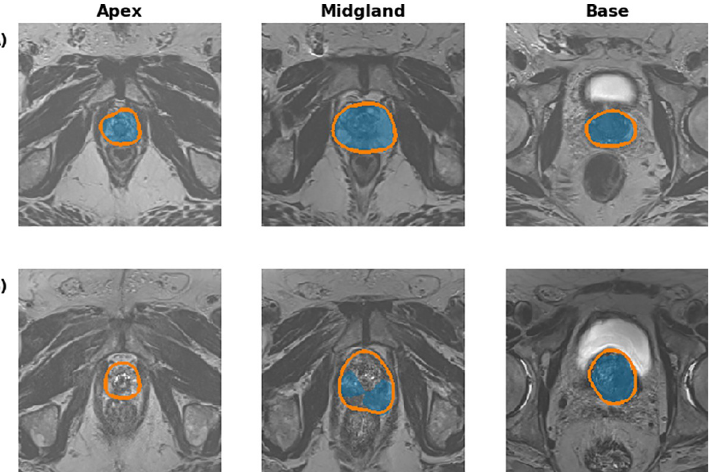
Fig 2. Example UCLA baseline model segmentations. The orange contour depicts ground truth segmentation and the shaded blue area depicts model segmentation. A ) Example apex, midgland, and base slice from a sample in the primary dataset with a high metric on evaluation. The soft Dice coefficient for this sample was 0.928, and the average Hausdorff distance was 0.085. Images of all of the slices for this study are presented in S1 Fig. B ) Example apex, midgland, and base slice from a sample in the primary dataset with a low metric on evaluation. The soft Dice coefficient for this sample was 0.738, and the average Hausdorff distance was 0.935. Images of all of the slices for this study are presented in S2 Fig